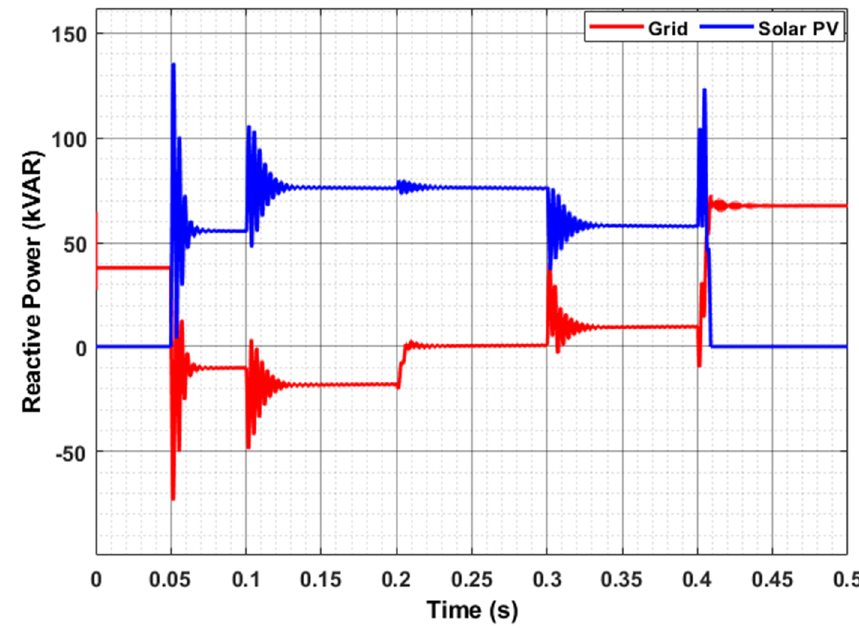
Figure 6. Reactive power-sharing between the utility grid and D.G.